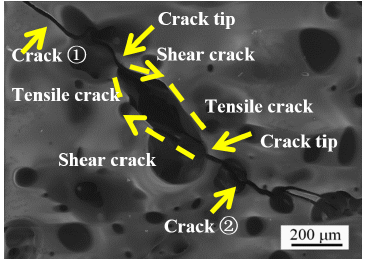
Figure 10. Tensile coalescence mode of crack coalescence.